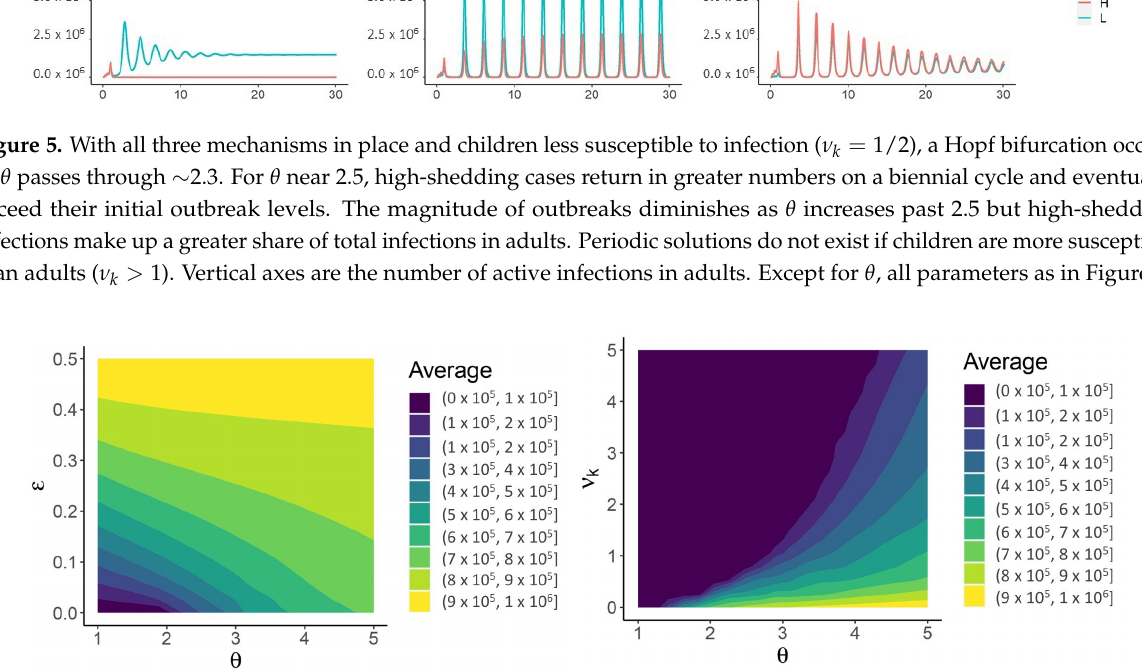
Figure 6. The Sweet Spot for JASC: the three mechanisms in combination limit the long-term average number of high- shedding cases if they generate low-shedding cases with probability close to 100% and provided that high-shedding cases are not too infectious ( (cid:101) ≈ 0, θ ≈ 1, ( left panel )). Children help mitigate disease severity if they develop low-shedding infections and are more susceptible than adults ( ν k > 1, ( right panel )). High-shedding infections can make up half of the total infection prevalence in adults if children do not acquire infection ( ν k < 1, right panel, and also refer to the θ = 5 case in Figure 5). High-shedding infections in adults are rare and periodic outbreaks will not occur if children are equally susceptible ( ν k = 1). Low-shedding infections in adults further decline if children are more susceptible ( ν k → ∞ ). Parametrization in the left panel corresponds to ν k = 1/2 and the parametrization in the right panel corresponds to (cid:101) = 0. See text for description of the other parameters.